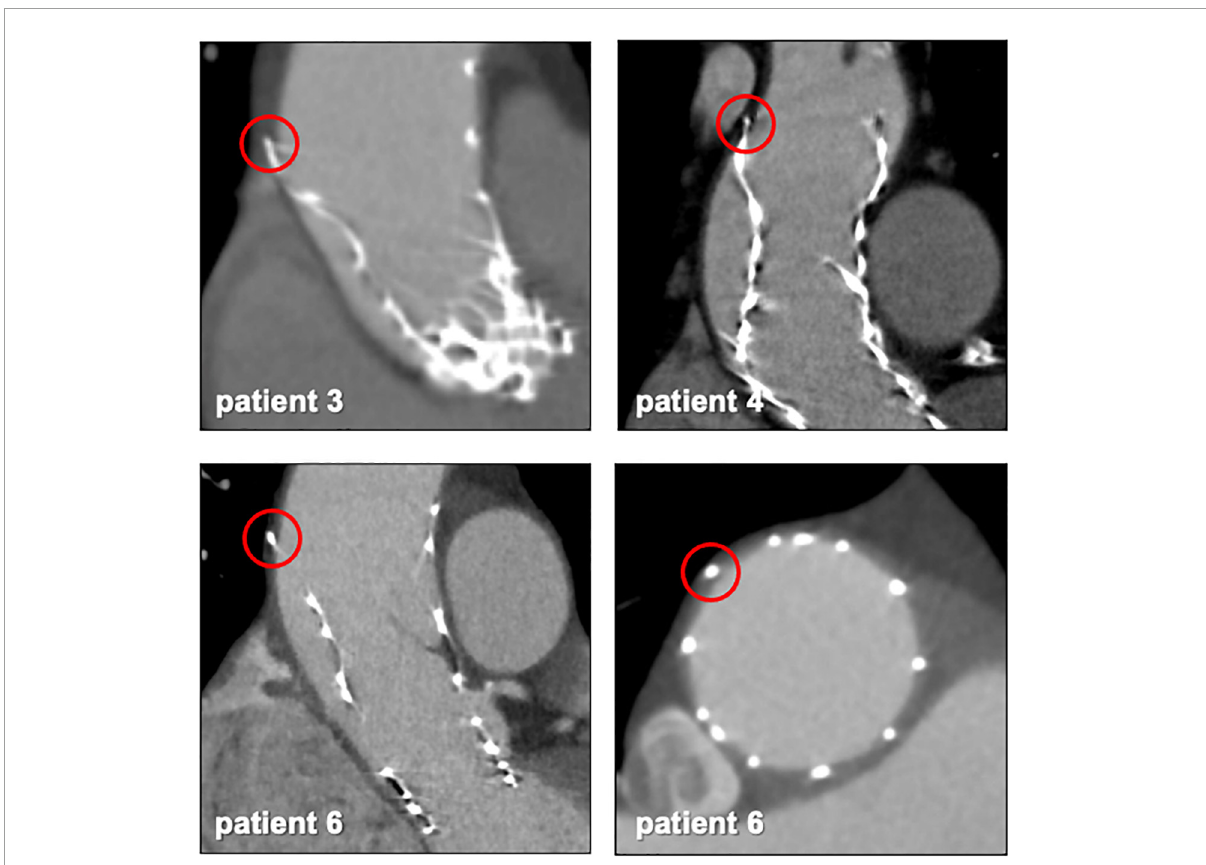
FIGURE3 Protruding stent frames into the aortic wall. CT follow-up images from patients 3, 4, and 6 ( Table 5 ) revealed parts of the upper crown of the stent frame protruding into the aortic wall.